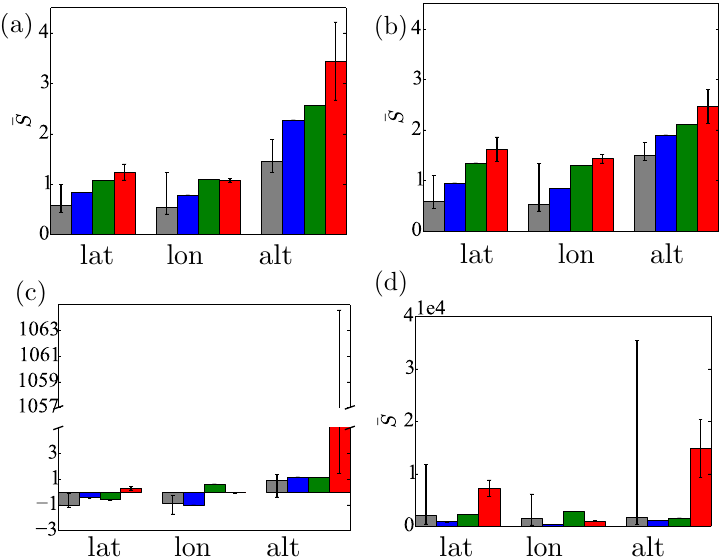
Figure 8. The time-averaged scores, S , are plotted ( a ) for the raw data with the standard deviation given by the stationary limit and ( b ) for the same dataset as in ( a ) except that the uncertainty is multiplied by the appropriate Dilution-Of-Precision (DOP) variable. ( c ) S from the unscented Kalman filter with OU noise model and ( d ) the unscented Kalman filter with iid Gaussian noise model. The colours are consistent with Figure 4. The scales of the ordinates are different in each figure; most importantly, in ( d ), it is 3 × 10 3 bigger than in the other